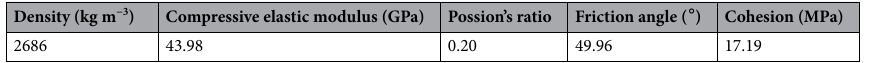
Table. 1.. Physical and mechanical properties of Sanshandao